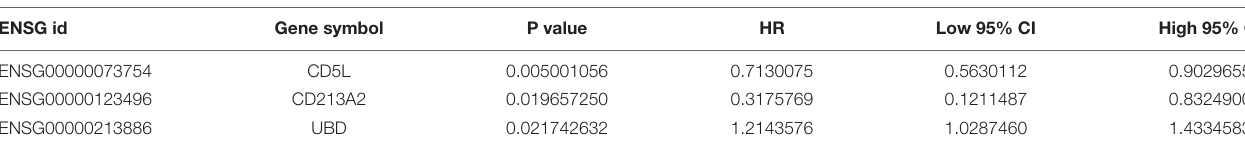
FIGURE 7 | Prognostic gene signatures related to DMEGs. (A) LASSO-regression frequencies for each combination of genes. (B) Change-coefficient trajectories for each of the three probe genes using different lambdas. (C) The distribution of standard deviations in this model under different lambda conditions. (D) Kaplan-Meier curves for the CD5L high- and low-expression groups. (E) Kaplan-Meier curves for the CD213A2 high- and low-expression groups. (F) Kaplan-Meier curves for the UBD high- and low-expression groups. TABLE 2 | LASSO identifies 3 prognostic-related